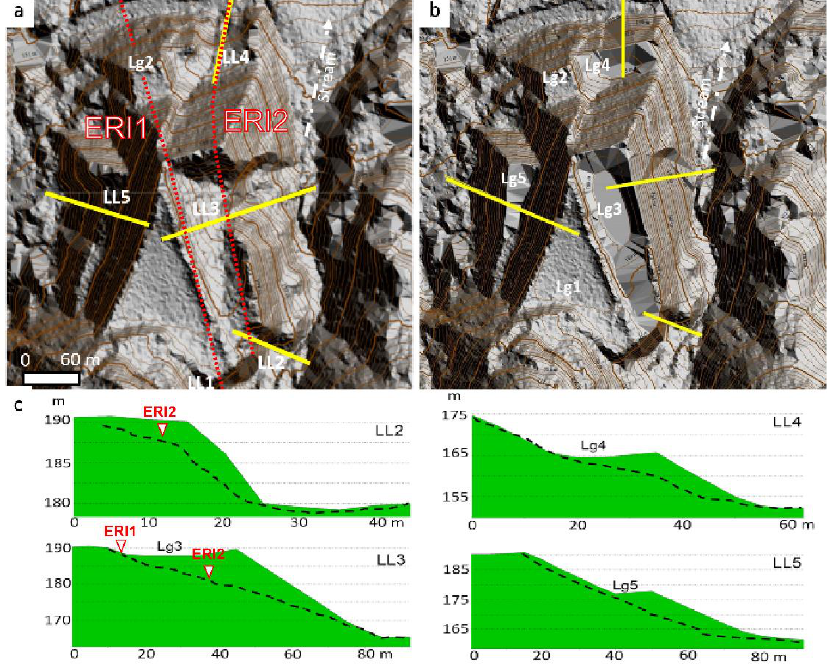
Figure 3. ( a ) ERI profiles layout on a hill shaded elevation models of El Descargador tailings dam; ( a ) actual state; ( b ) tentative reconstruction of the relief before the 1963′s failure; and ( c ) Representative topographic profiles of the main landslide before (green) and actual surface of failure dashed lines. The white dashed arrow indicates the stream runoff direction.